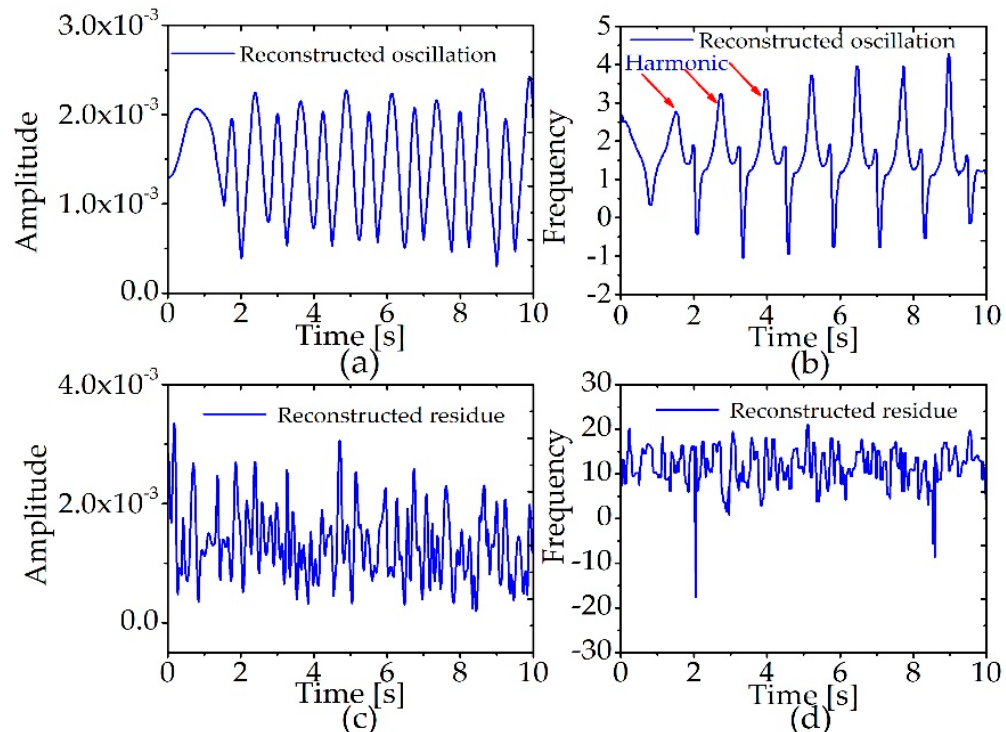
Energies 2019 , 12 , x FOR PEER REVIEW 13 of 26 Figure 9. The instantaneous amplitudes (IA) and instantaneous frequencies (IF) by Hilbert transform (HT) for both oscillations and residual after implemented SSA method, ( a ) the IA of oscillations, ( b ) the IF of oscillations, ( c ) the IA of residual, ( d ) the IF of residual in the simulation. Table 2. Features time domain of the error indexes of reconstructed oscillations via the empirical mode decomposition (EMD) technique and the singular spectrum analysis (SSA) technique and the error indexes of the rebuilt residue via SSA technique. (Unit: °).